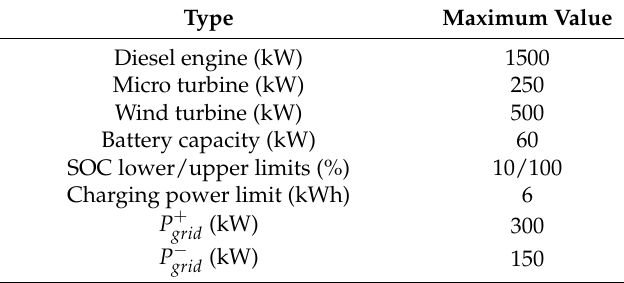
Table 1. Data of capacity limits.